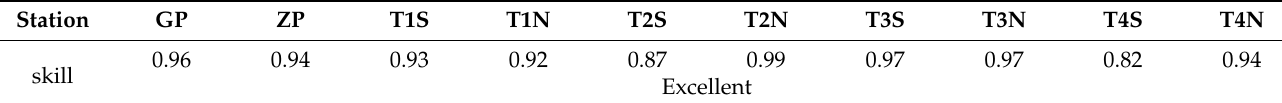
Table 2. Model observation data comparison statistics for the tide